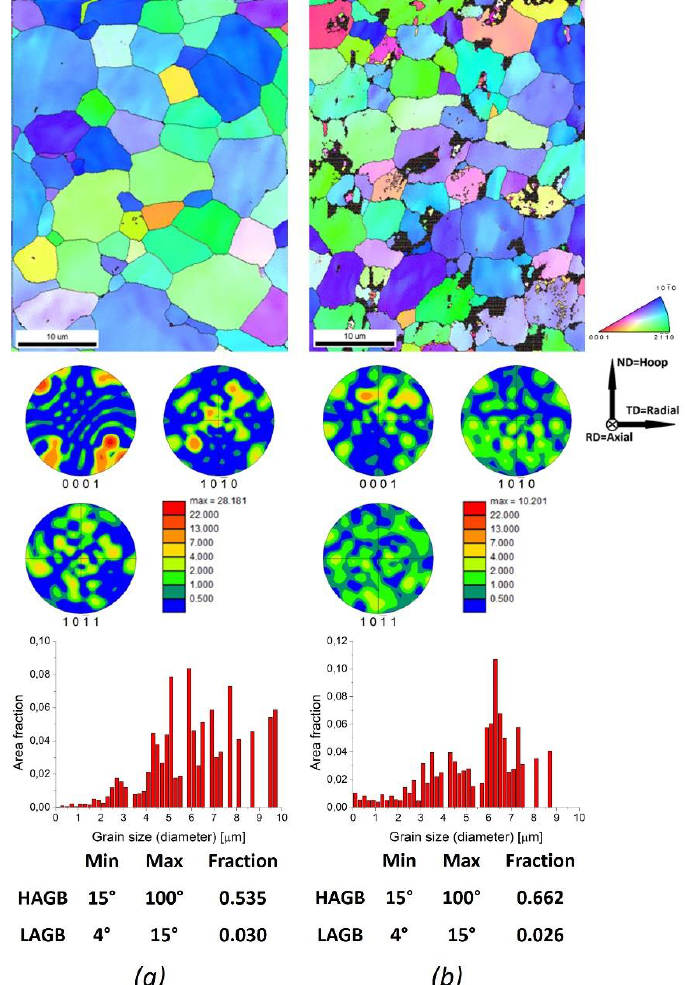
Figure 4. Grain orientation maps, local micro-textures, grain size distributions, and the low- and high-angle grain boundaries (HAGB and LAGB) fractions of the initial state in the periphery ( a ) and in the center of the sample ( b